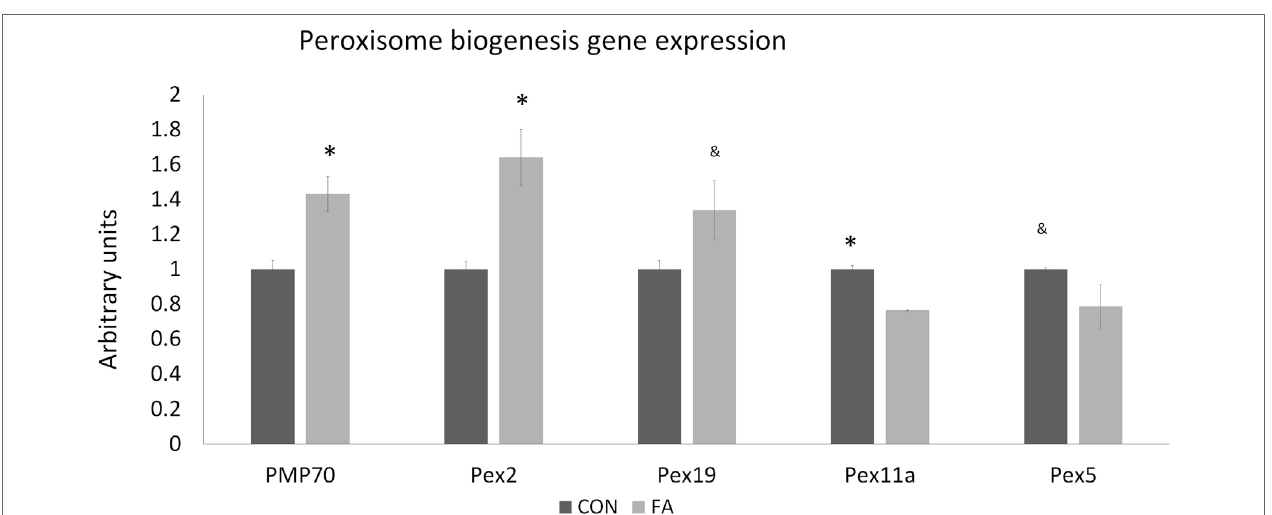
FigUre 5 | The mRNA expression of the genes related to peroxisome biogenesis of C2C12 cells in control (CON) and EPA/DHA (FA) medium. Data show the change of their mRNA expression in FA group compared with CON group. The relative expressions were calculated in arbitrary units. * P < 0.05 and & P < 0.1; n = 3.